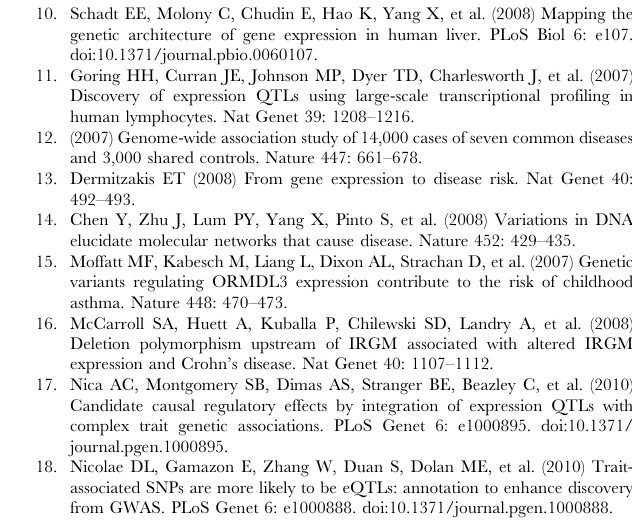
Figure S2 SNP 6 tissue interaction p-value from repeated measures ANOVA for all, shared and tissue-specific eQTLs respectively. Greater enrichment of significant SNP 6 tissue p- values is observed for tissue-restricted effects. Figure S3 eQTLs (10 2 2 PT, SRC) shared in all three tissues tested have the same direction of allelic effect (SRC rho) across tissues. Figure S4 Cumulative SRC rho distribution across tissues for tissue-specific and shared eQTLs (10 2 3 PT, Twin1). eQTLs discovered in one tissue only have distinctively higher variance in the tissue of discovery compared to shared effects. Figure S5 Most regulatory signals come from single independent eQTLs (SRC, 10 2 2 PT). Figure S6 Distribution of independent cis eQTLs (10 2 3 PT, SRC) around TSS, Twin 1. Figure S7 Distribution of independent cis eQTLs gained with FA correction (10 2 3 PT) around TSS, Twin 1. Figure S8 Fold change within twins and across tissues for SKIN eQTLs (10 2 3 PT, SRC) discovered in Twin 1. Fold change was calculated as the difference in mean expression of the heterozygous and major homozygous genotypic classes. For each pairwise tissue comparison, the Pearson’s correlation coefficient between fold changes is shown.